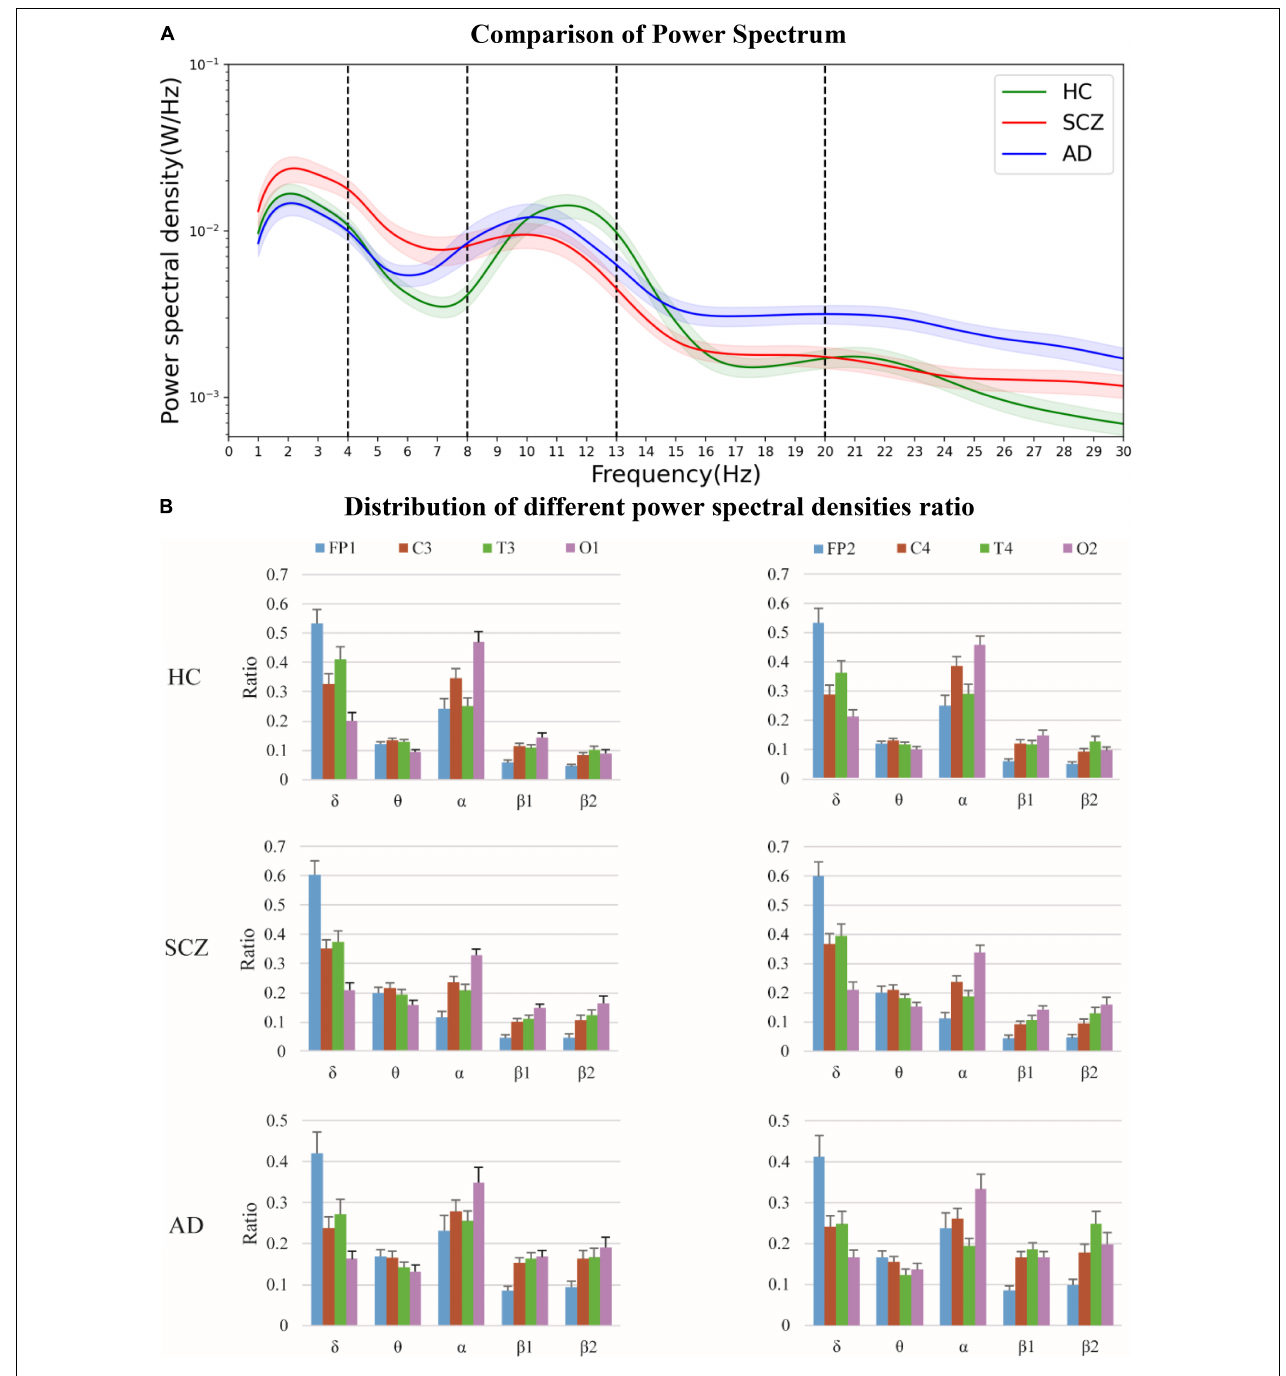
FIGURE 4 | The power spectra were analyzed in HC, and in patients with SCZ, and AD, respectively, together with extracted power spectral density ratios of different brain regions. (A) Comparison of power spectrum. (B) Distribution of different power spectral densities